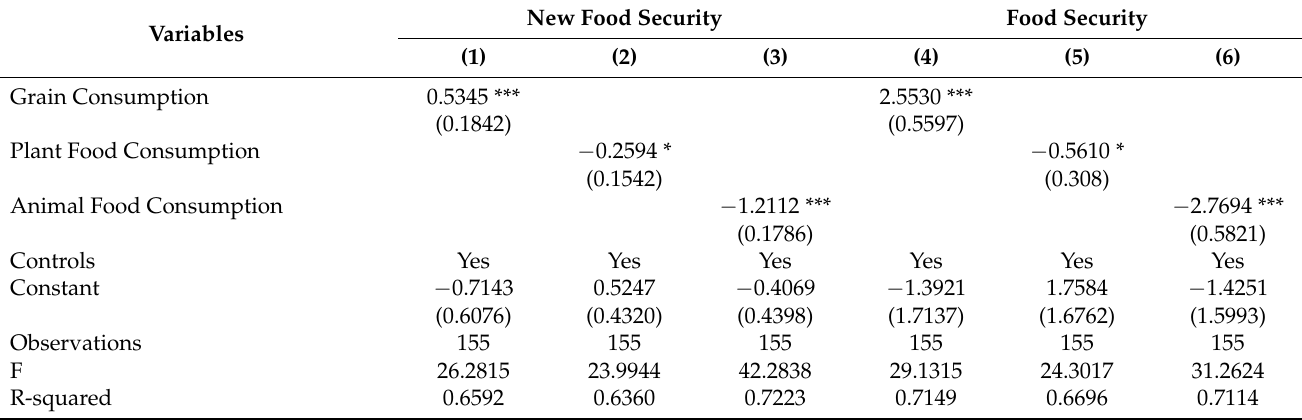
Table 8. Robustness Test